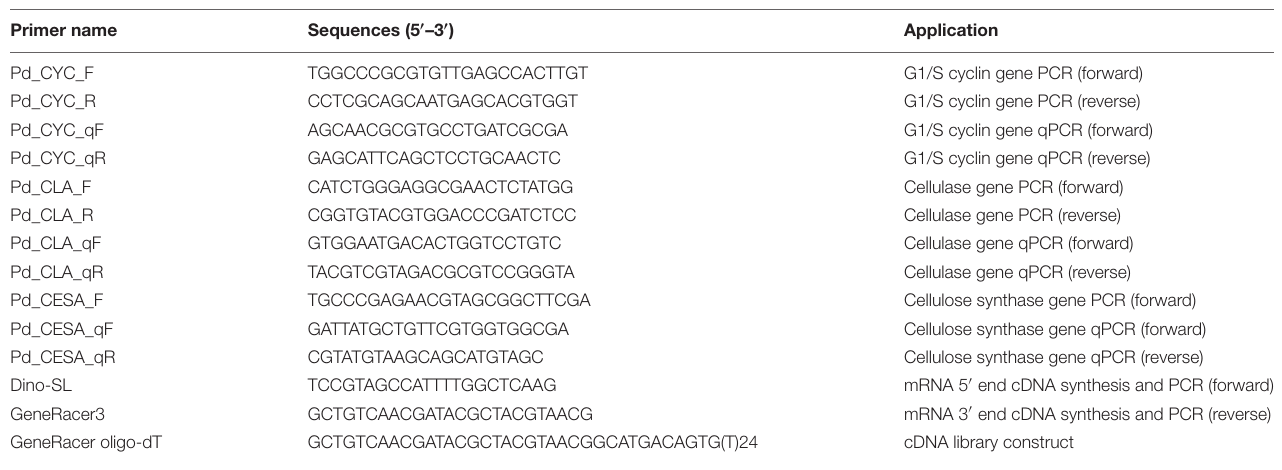
TABLE 1 | Primers used in this